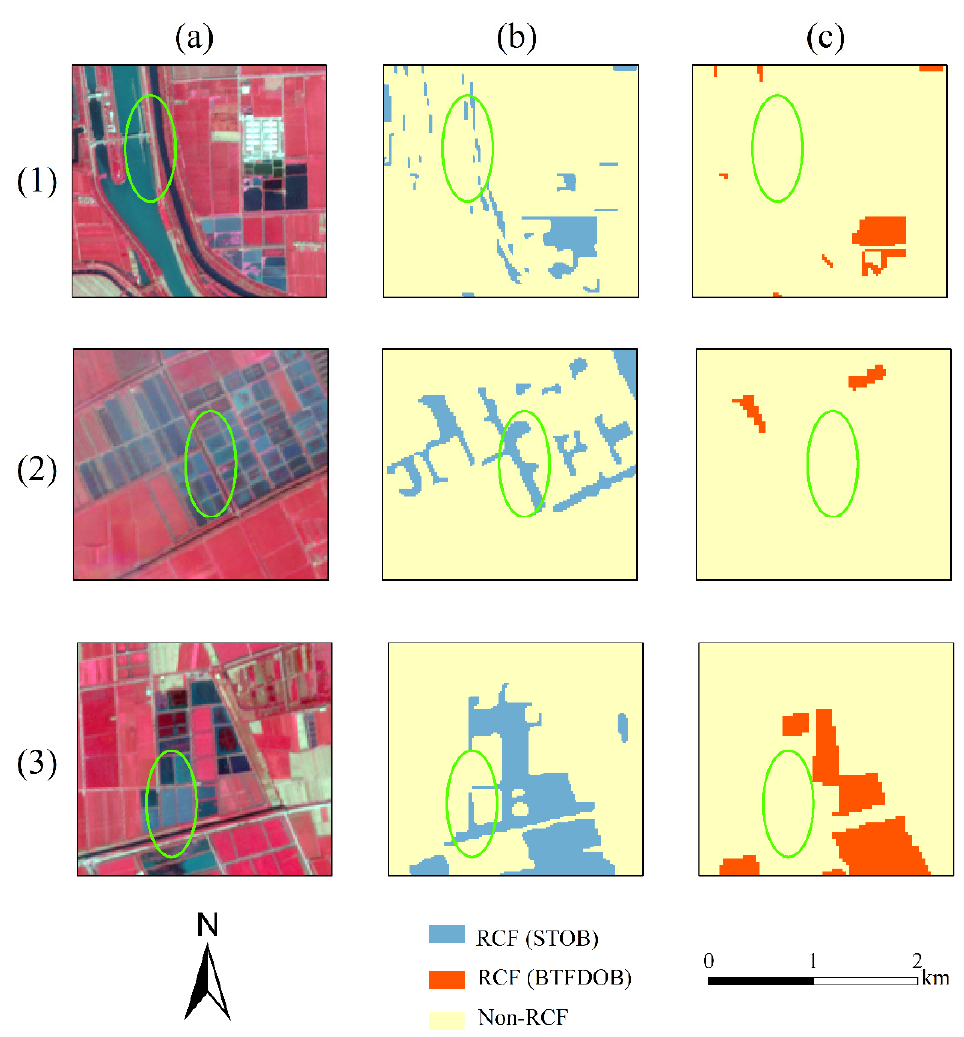
Figure 11. Comparison of the two classification methods in terms of rice–crayfish classification in typical regions. Rows (1)–(3) show three typical regions; column ( a ) shows the false-color optical Sentinel-2 image from October 2021; columns ( b , c ) show the RCF maps of STOB and BTFDOB, respectively, corresponding to the places in column ( a ).